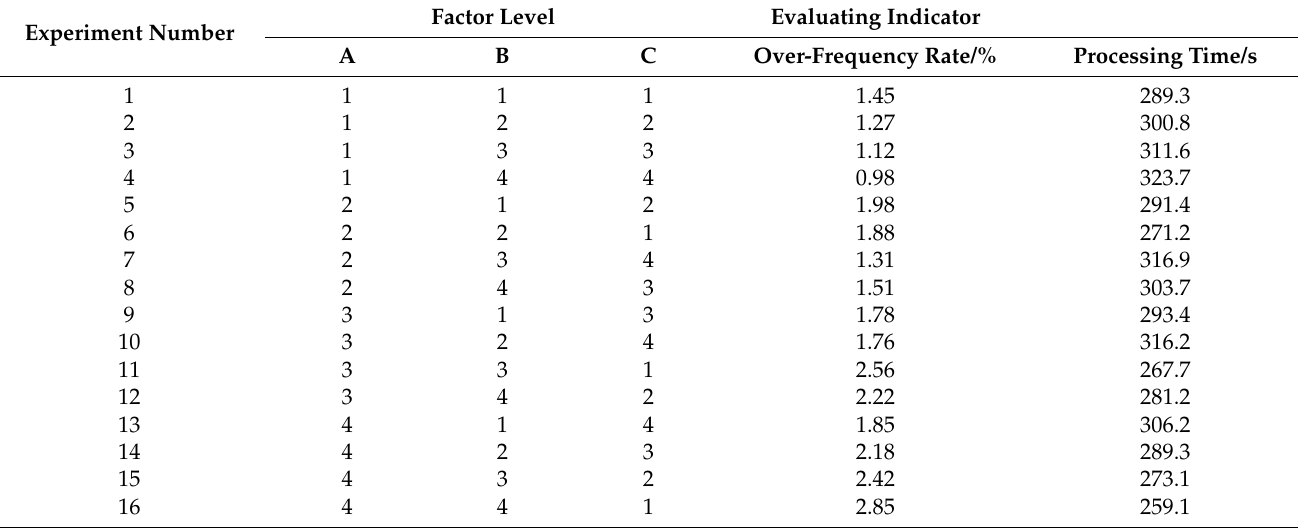
Table 8. L 16 (4 5 ) Orthogonal experiment and